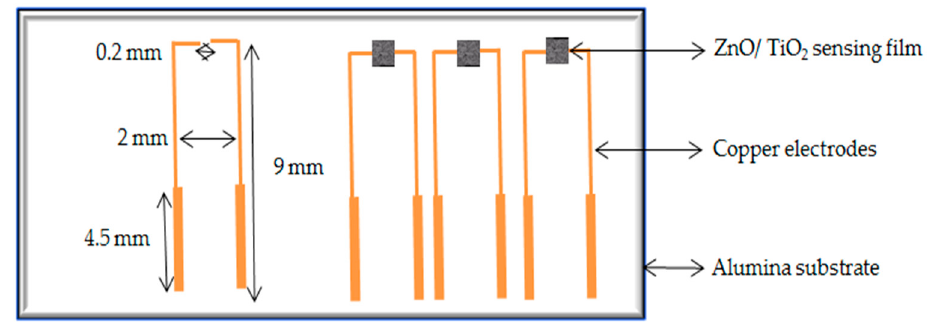
Figure 2. Configuration of the ZnO/ TiO 2 sensors.